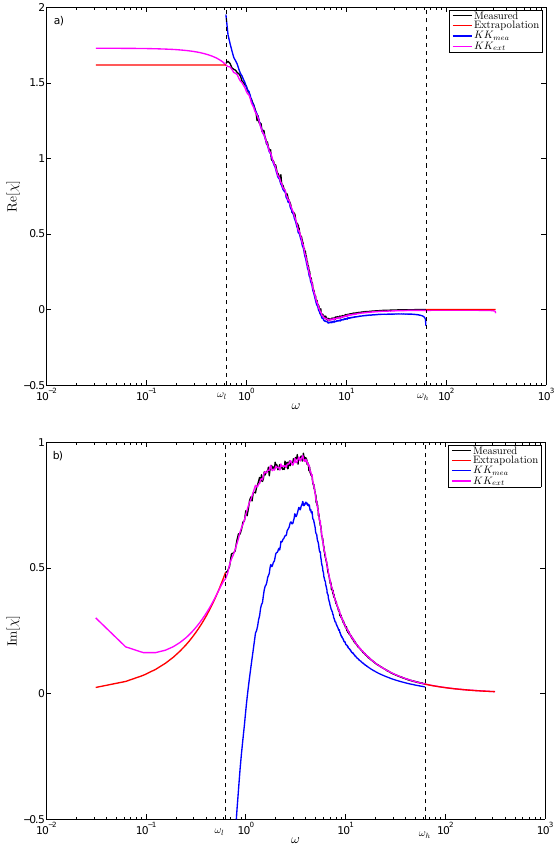
Fig. 2. Linear susceptibility of intensive momentum of the system M/N with respect to the global perturbation with X i = 1 ∀ i . The real and the imaginary parts are depicted in (a) and (b) , respectively. The measured and extrapolated values are shown in red and black lines, respectively. The result of the Kramers-Kronig inversion done with the measured and with with the extrapolated data are shown in blue and magenta lines,